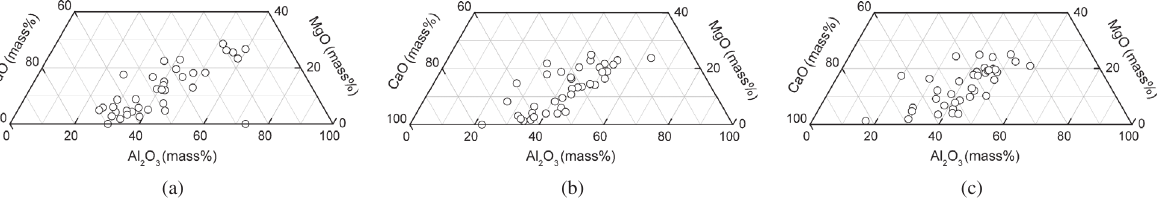
Figure 1 : Composition distribution of inclusions in steel samples of pre-equilibrium experiments. (a) 90 min holding; (b) 90 min holding; (c) 120 min holding.